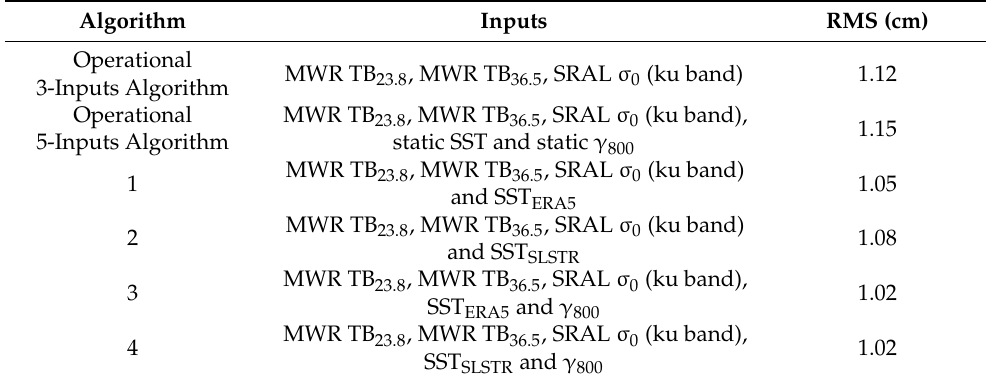
Table 5. Global RMS of the WPD differences between operational and developed algorithms against SI-MWR.